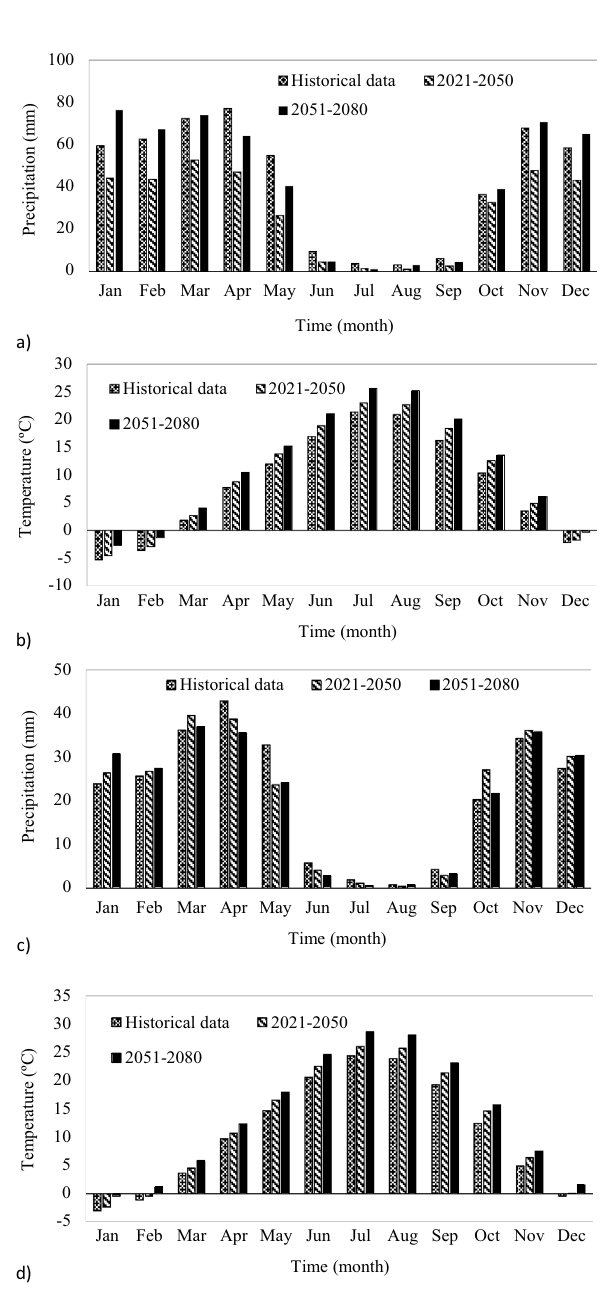
Figure 5. Average monthly precipitation and temperature in the Bukan sub-basin corresponding to the historical period and two future periods: ( a ) precipitation in the upstream region; ( b ) temperature in upstream region; ( c ) precipitation in the downstream region; (d) temperature in the downstream region.